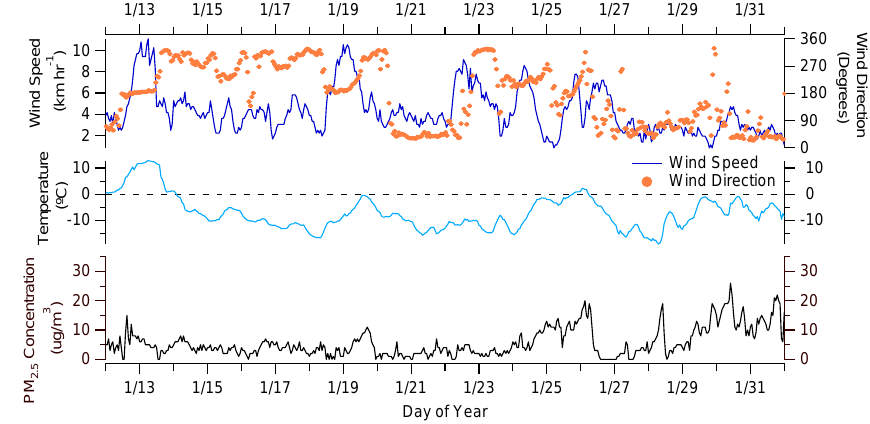
Figure 2. Meteorological conditions and PM 2 . 5 mass concentration from the CRUISER TEOM for the MicMac Park winter campaign.